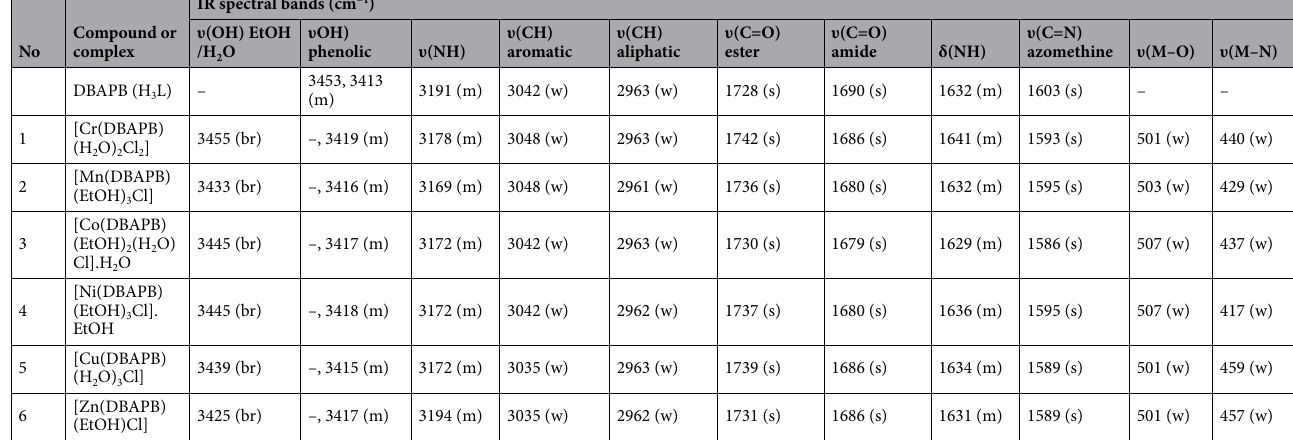
Table 2. IR spectral data (cm −1 ) of the Schiff base ligand, DBAPB, and its metal complexes. br broad, m medium, w weak, s strong.